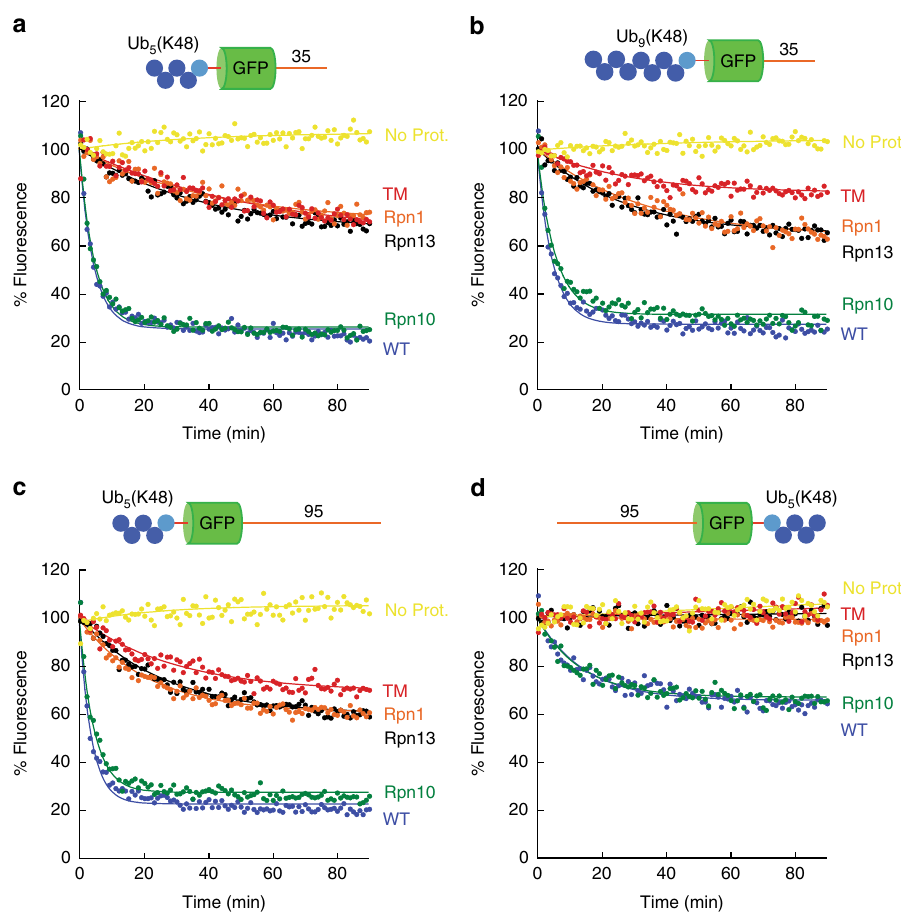
Fig. 2 Degradation of substrates with K48-linked polyubiquitin chains. Degradation of substrate proteins with K48-linked ubiquitin chains by the indicated proteasome mutants was followed under single-turnover conditions (5 nM substrate, 25 nM proteasome) in the presence of 1 mM ATP at 30 °C. The graphs show substrate fl uorescence as a percentage of the initial fl uorescence as a function of time in minutes. Proteasome types are described in Supplementary Table 1 (TM triple mutant proteasome). Each panel shows the degradation of particular substrates, and as follows: a Ub 5 (K48)-GFP-35; b Ub 9 (K48)-GFP-35; c Ub 5 (K48)-GFP-95, and d 95-GFP-Ub 5 (K48). Source data are provided as a Source Data fi proteasomes in which Rpn1, Rpn10, and Rpn13 all carry substitutions are referred to as TM (triple mutant) proteasomes.